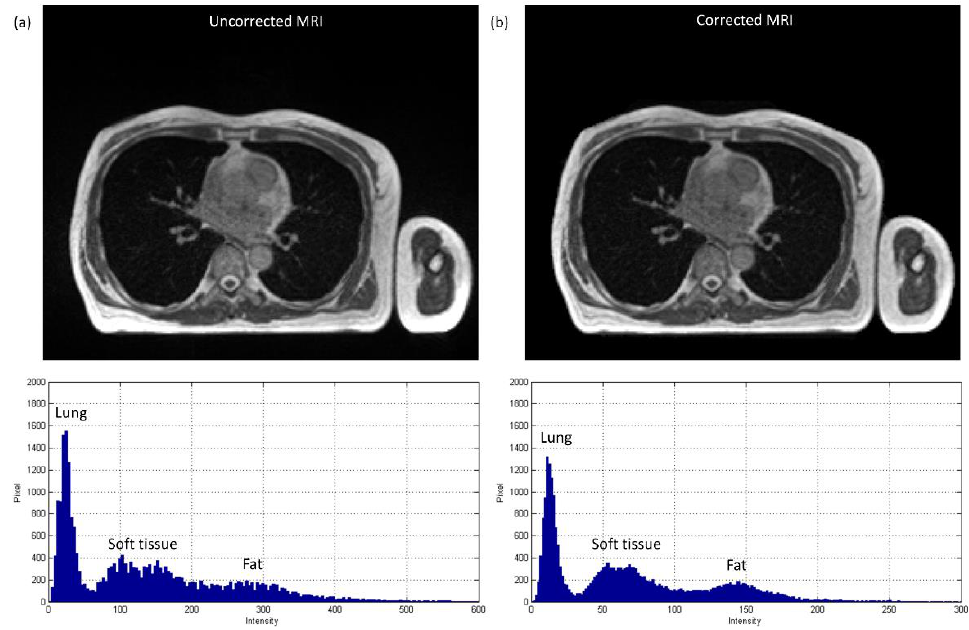
Figure 6. Axial image and histogram of ( a ) uncorrected MRI (WL/WW = 200/400) and ( b ) corrected MRI (WL/WW = 100/200) from 0.35 T scanner for chest imaging divided into CNN testing dataset ( IMG testingchest ).